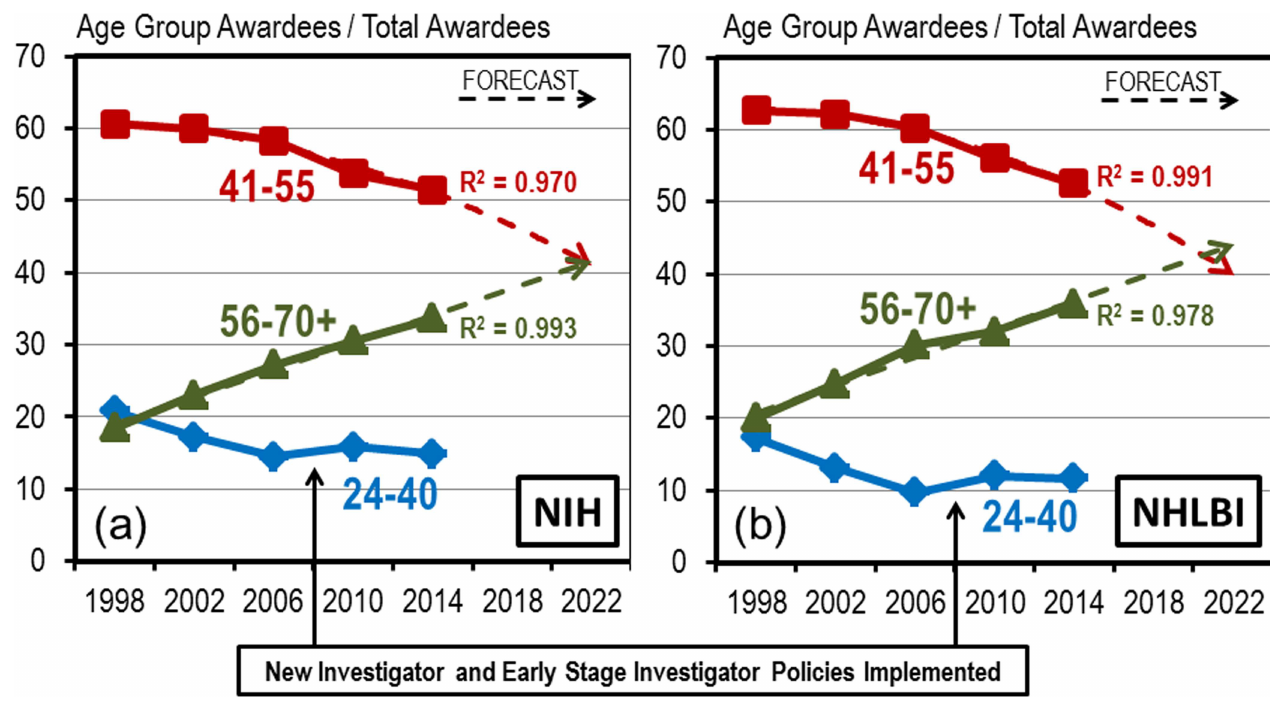
Fig 4. Demographics of RPG Awardeesis Shifting towards an Older Population. Proportionof RPG awardees by age group (blue diamond= ages 24–40, red square = ages 41–55,green triangle= ages56-70+) for select years between 1998and 2014 for (a) NIH and (b) NHLBI. Dashedlines are trend line forecasts through the data curves with R 2 values